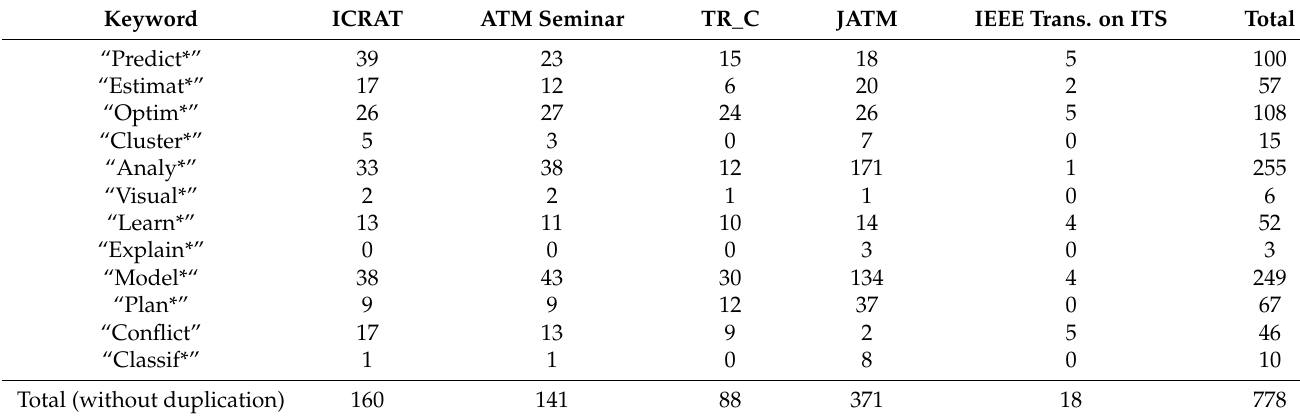
Table 2. Paper selection result at the identification